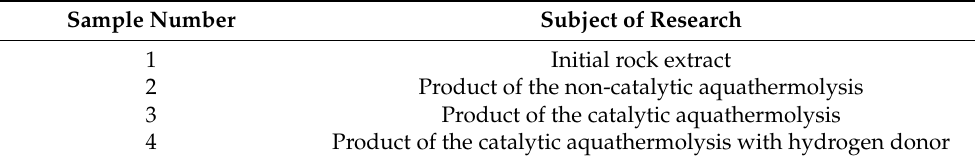
Table 2. Model system.